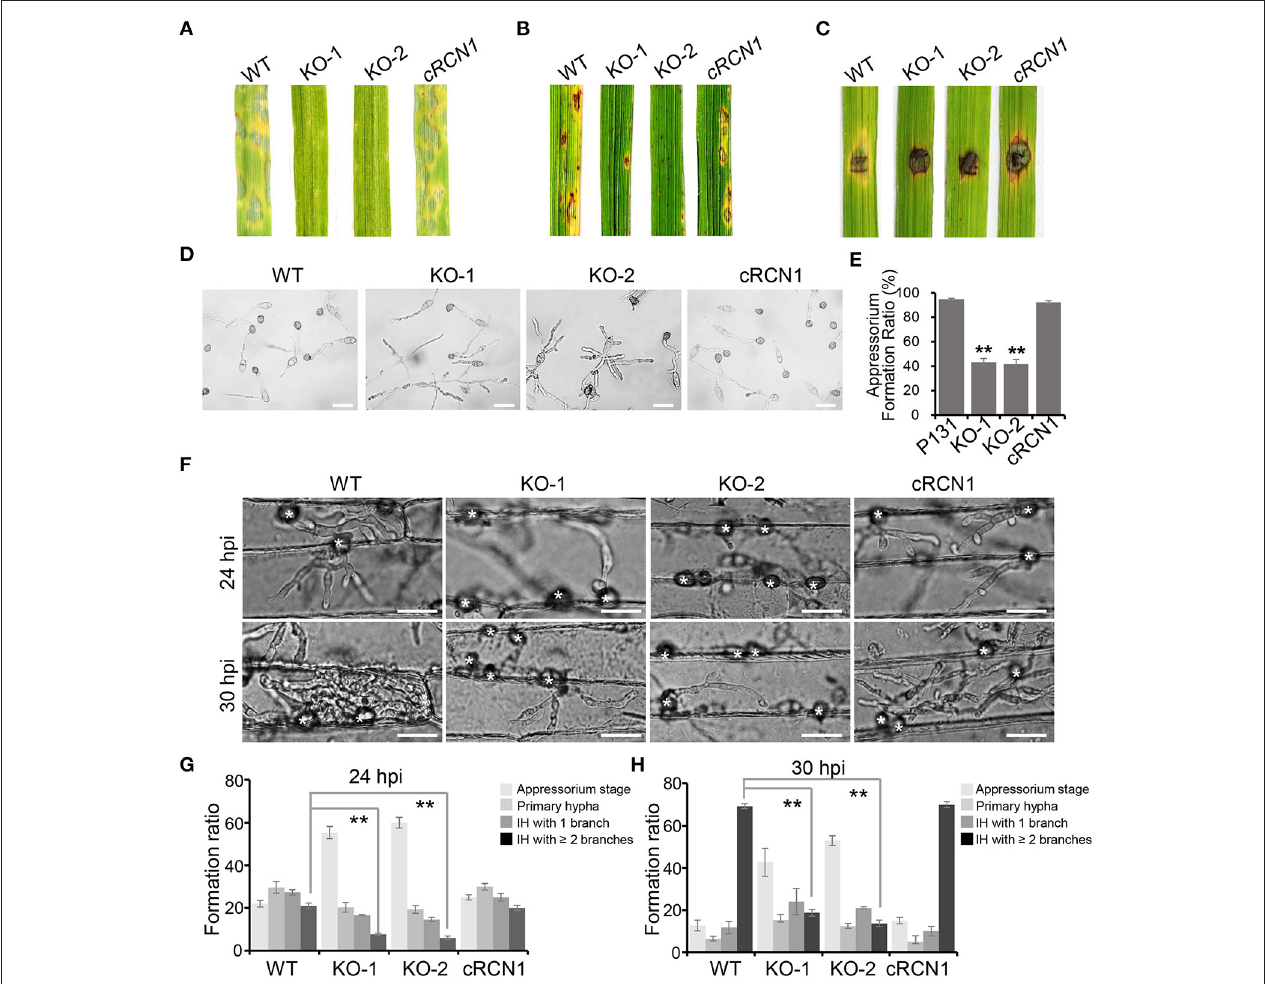
FIGURE 2 | Deletion mutants of MoRCN1 lead to severe reduction in virulence. (A) Virulence test on barley leaves. Lesions formed on barley leaves were sprayed by conidia (3 × 10 4 conidia/ml) of indicated strains and observed at 5-day post inoculation (dpi). (B) Virulence test on rice seedlings. Lesions formed on rice leaves were induced by spray inoculation with conidia (1.5 × 10 5 conidia/ml) of indicated strains and observed at 5 dpi. (C) Lesions formed on wounded rice leaves. The wounded rice leaves were inoculated by mycelia blocks of different strains and observed at 4 dpi. (D) Appressorium formation were observed under a light microscope. The conidia of tested strains were inoculated on hydrophobic surfaces and calculated at 18 hpi. Bar 30 µ m. (E) Statistical analysis of appressoria formation ratio. Error bars represent the standard deviation, and asterisks represent significant differences among strains ( P < 0.01). (F) Invasive hyphae (IH) formed in barley epidermal cells infected by different strains at 24 and 30 hpi. Bar = 30 µ m. (G) Formation ratio of different patterns of infection structures at 24 hpi. (H) Formation ratio of different patterns of infection structures at 30 hpi. For (G) and (H) , percentages of appressoria (AP), primary invasive hyphae (PH), and IH with branches in barley epidermal cells were calculated. Means and standard deviation were calculated from three independent replicates. Significant differences compared to the WT are indicated by asterisks ( P <